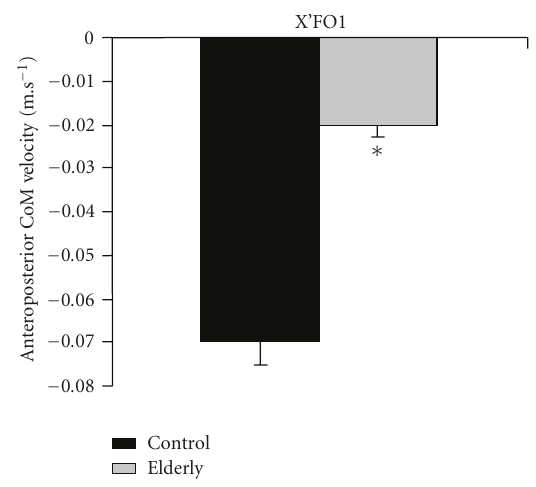
Figure 8: Anteroposterior CoM velocity at foot-o ff during stepping down. ∗ denotes being significantly di ff erent from control subjects ( P < . 05).